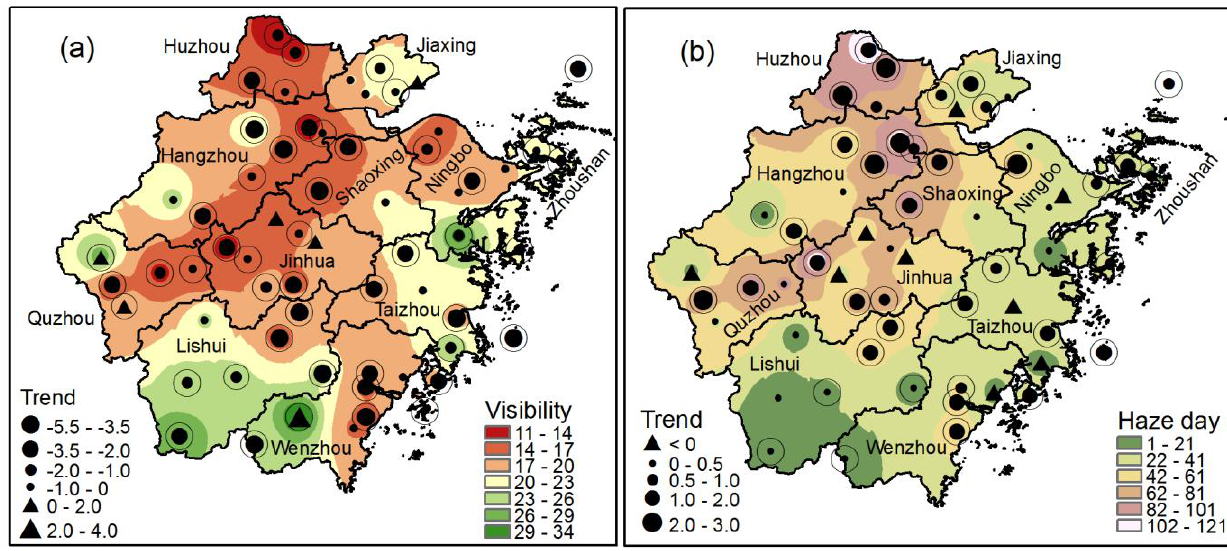
Figure 8. Spatial distribution of ( a ) annual mean visibility (11-year average for the period 2001–2011) and the trend in annual mean visibility (1980–2011); ( b ) annual mean haze days (11-year average for the period 2001–2011) and the trend in annual haze day change (1980–2011).